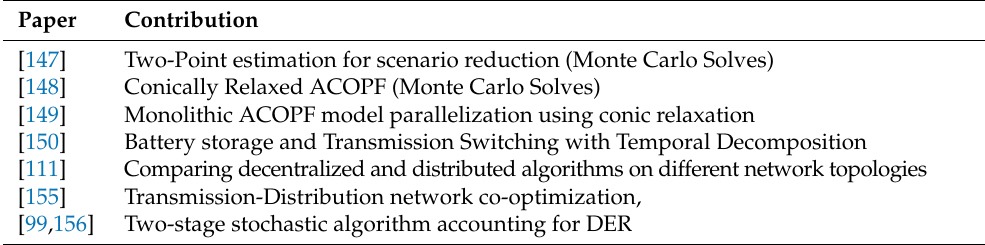
Table 4. Optimal Power Flow MIMD based state-of-the-art studies.